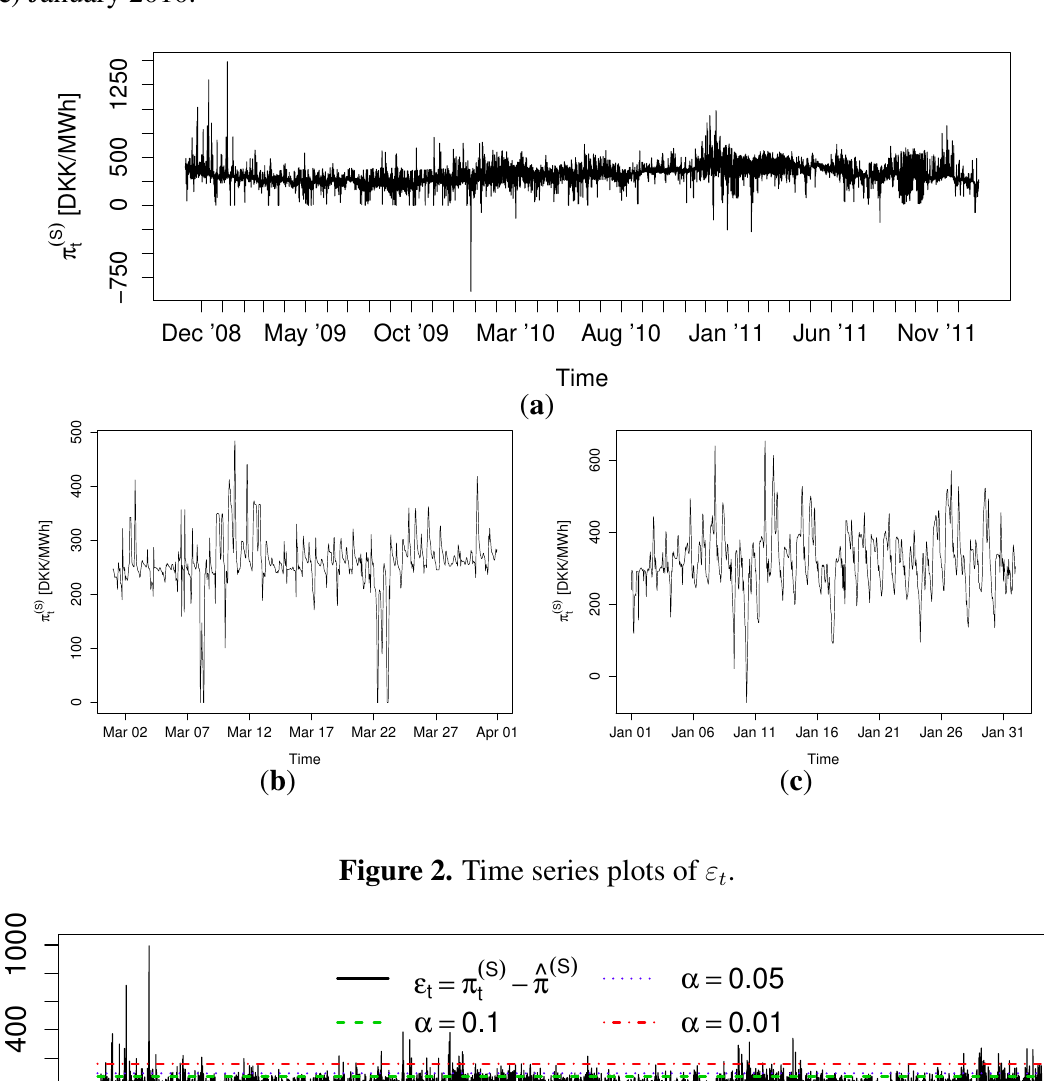
Figure 1. Time series plots of π ( S ) ( c ) January 2010.